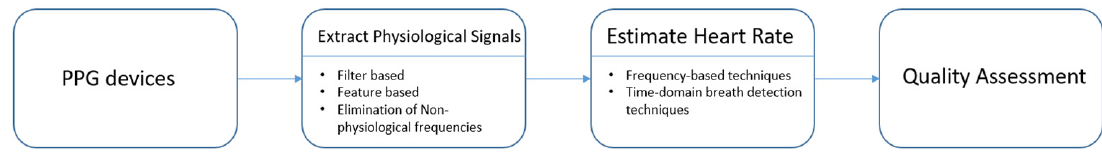
Table 1. Previous survey papers on contact-based PPG